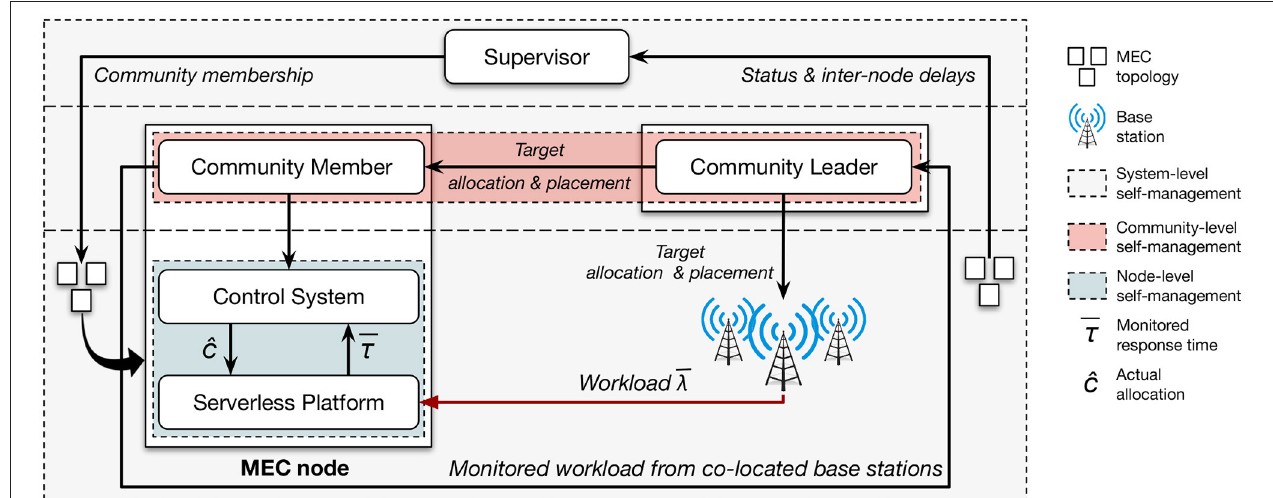
FIGURE 2 | PAPS in a